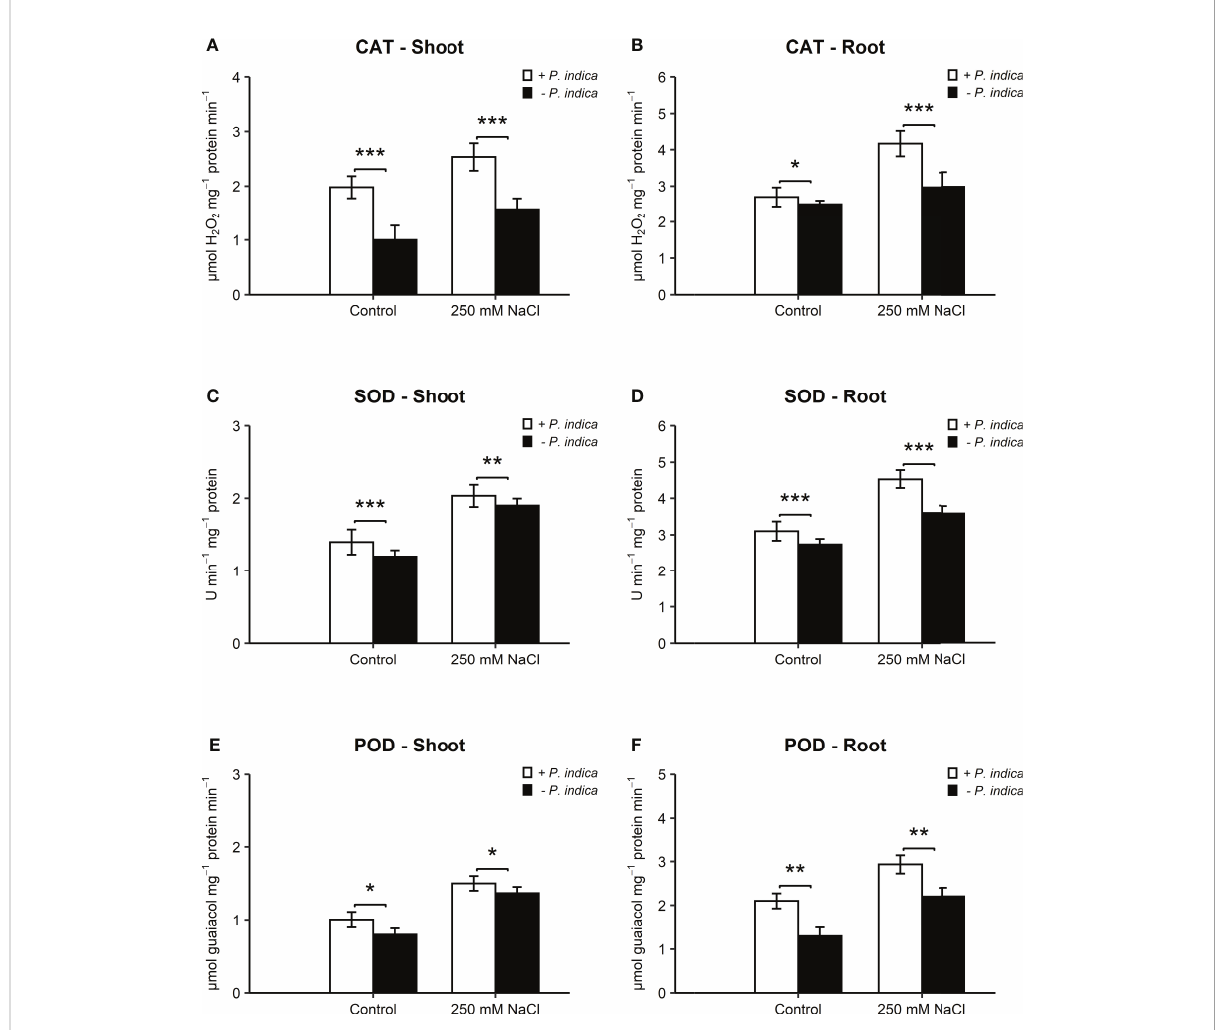
FIGURE 4 Antioxidant activity of date palm seedlings inoculated and non-inoculated with P. indica under control and salinity stress conditions. (A) Shoot content of CAT. (B) Root content of CAT. (C) Shoot content of SOD. (D) Root content of SOD. (E) Shoot content of POD. (F) Root content of POD. The values are the means ± SD (n = 3), analyzed by Student ’ s t- test, *p < 0.05, **p < 0.01, and ***p <